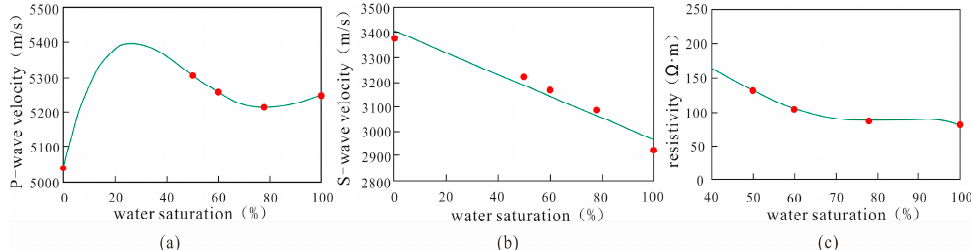
Figure 6. Relationship curves between P − wave velocity, S − wave velocity, resistivity and water sat ‐ uration.